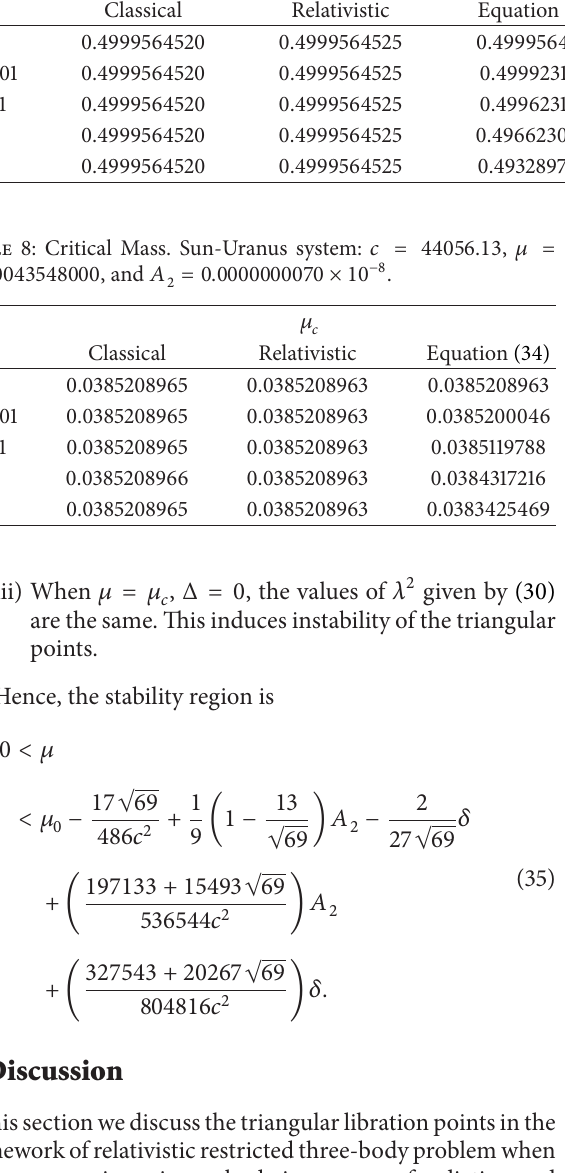
Table 7: Locations of triangular points. Sun-Uranus system: 𝑐 = 44056.13 , 𝜇 = 0.000043548000 , and 𝐴 2 = 0.0000000070 × 10 −8 . 𝜉 ±𝜂 𝛿 Classical Relativistic Equation (14) Classical Relativistic Equation (14) 0.0